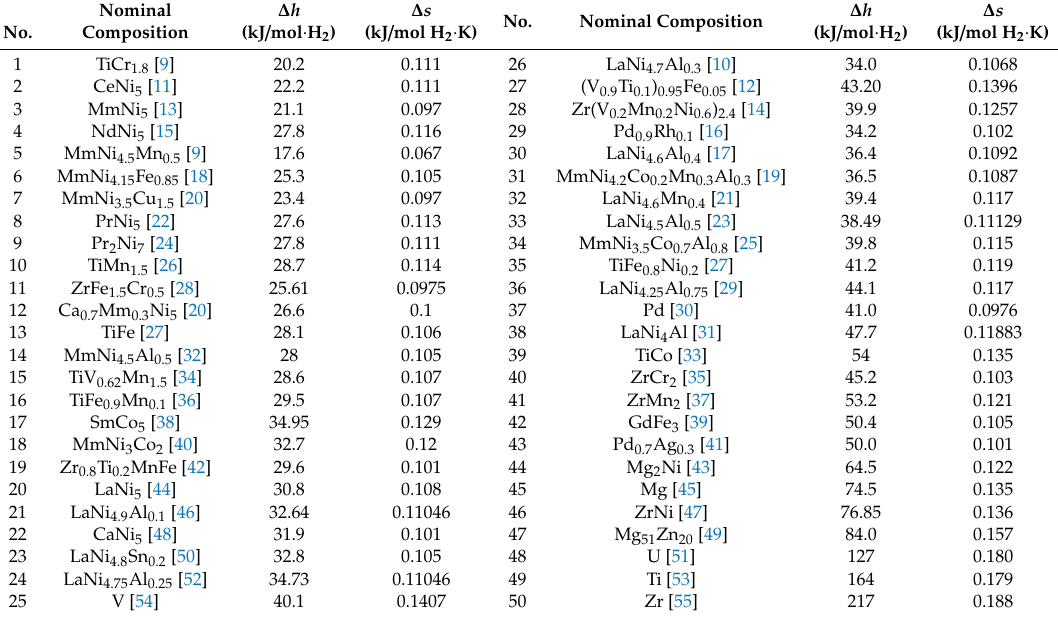
Table 1. Thermodynamic equilibrium properties of metal hydrides reported in various peer-reviewed journal articles. ∆ h is reaction enthalpy, and ∆ s is reaction entropy measured in the desorption process. ∆ h ∆ s Nominal No. Composition (kJ / mol · H 2 ) (kJ / mol H 2 ·